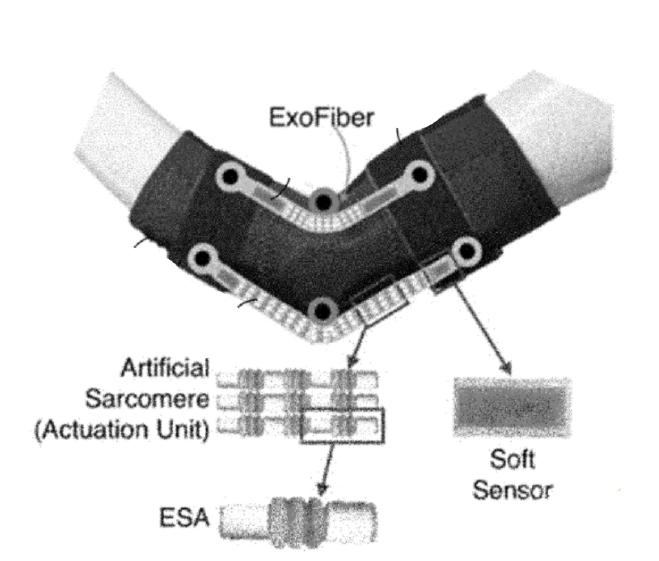
Figure 6. Conceptual schematic of bio-inspired arrangement of networked